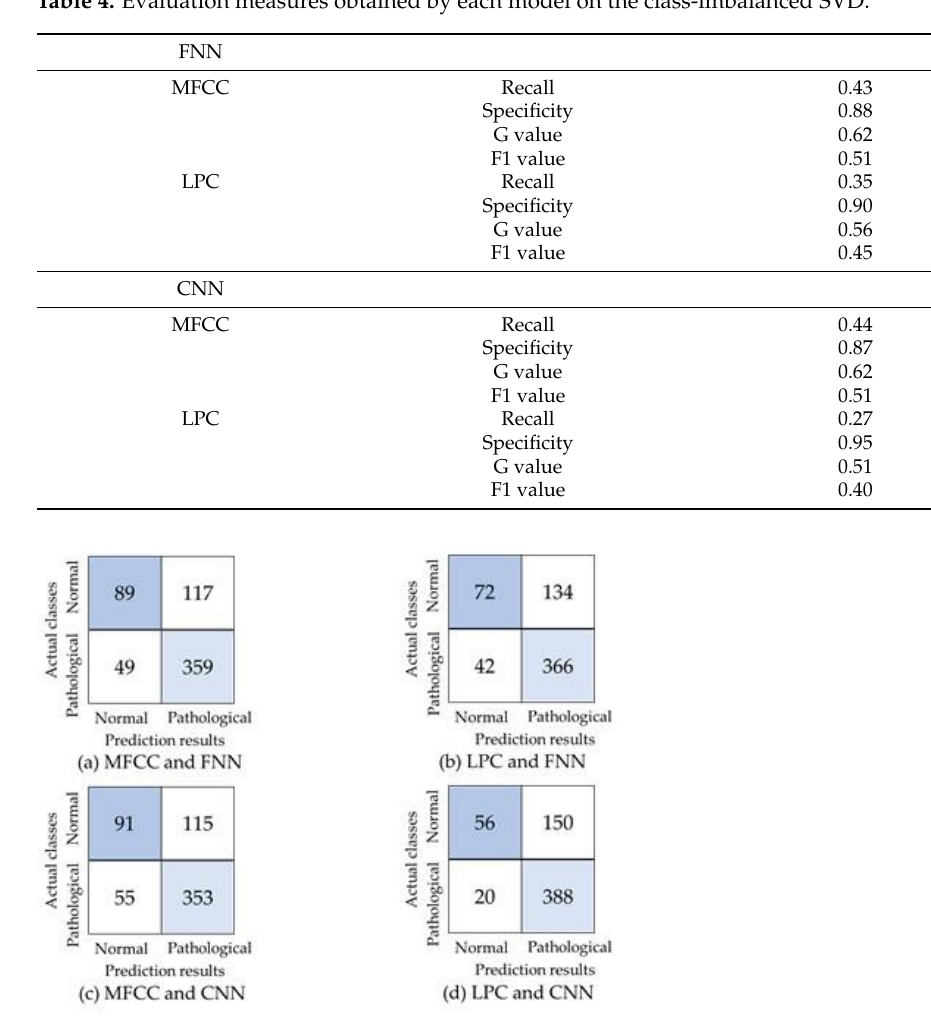
Figure 7. The confusion matrices produced for the MFCCs and LPCs by the FNN and CNN on the initial class-balanced dataset. initial class-balanced dataset.